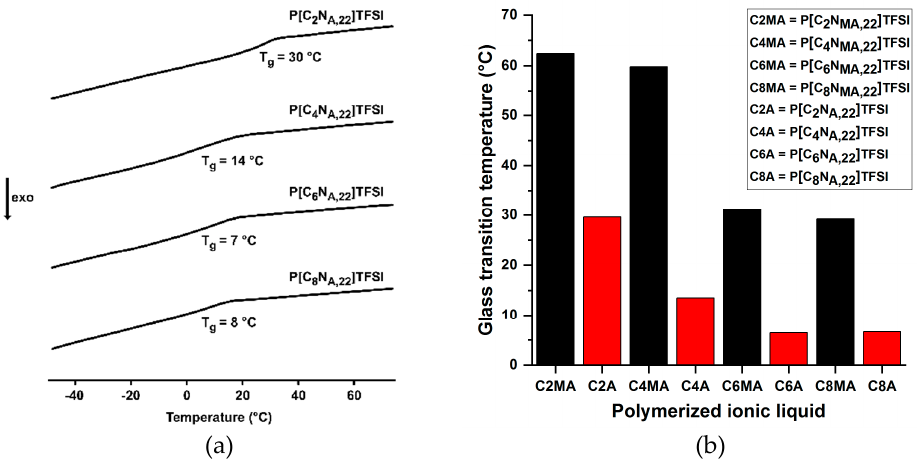
Figure 3. ( a ) Exemplary DSC data for the neat acrylate-PIL materials ( b ) Glass transition temperatures of the polymerized methacrylate (MA) and acrylate (A) containing ionic liquids.